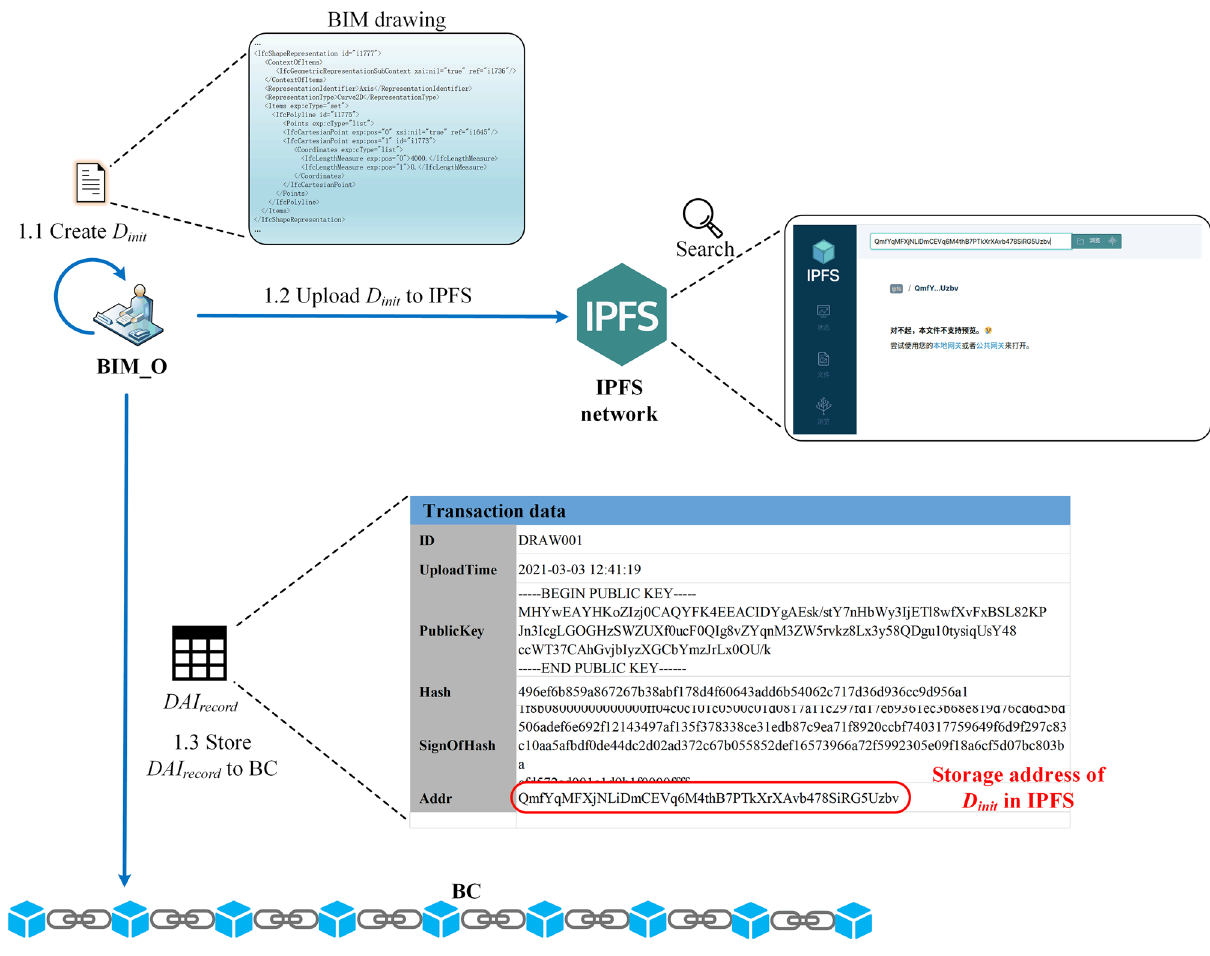
Figure 16. Example: BIM_O initializes BIM